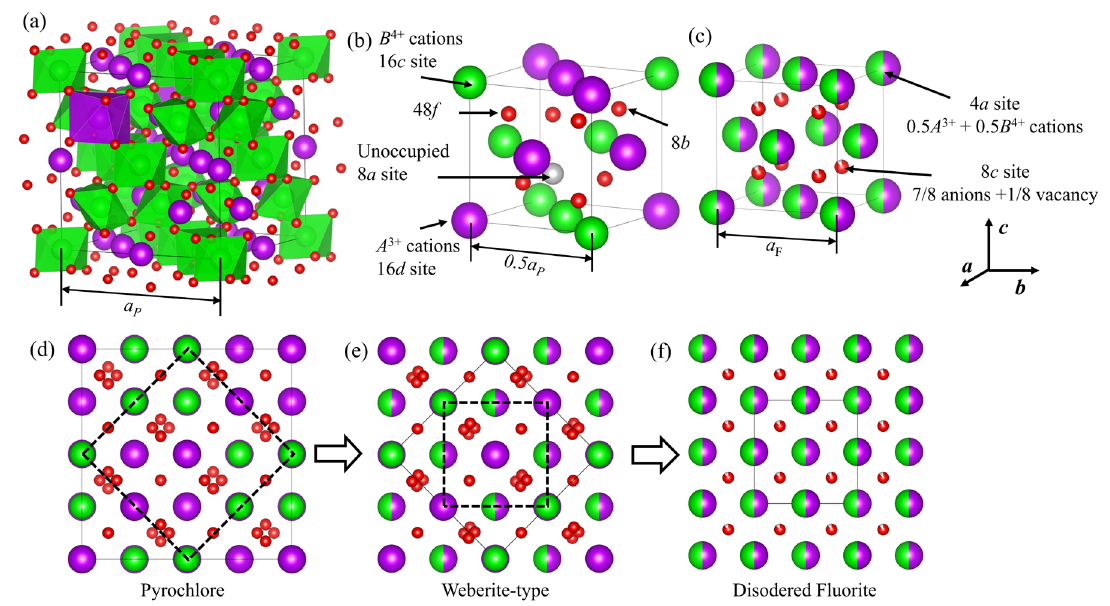
Figure 1. Pyrochlore structures described based on ( a ) the polyhedral network and ( b ) the derivative of fluorite structure, which is one eighth of the conventional unit cell of pyrochlore. Corresponding fluorite unit cells ( c ) are included for comparison. ( d – f ) Structural relations between the ( d ) pyrochlore, ( e ) weberite-type, and ( f ) disordered fluorite. Both the pyrochlore and weberite-type structures are supercells of disordered fluorite with unit cell parameters of a P = a WB = 2 a F and b WB ≈ c WB ≈ 2 1/2 a F (the subscripts refer to pyrochlore, weberite-type and disordered fluorite respectively). Red spheres represent oxygen sites that are fully occupied in the pyrochlore and weberite-type structures, and grey spheres represent oxygen vacancy. Purple and green spheres represent A -site (CN = 8) and B -site (CN = 6) cations, respectively. Half-purple and half-green spheres designate cation site mixing (CN = 7).